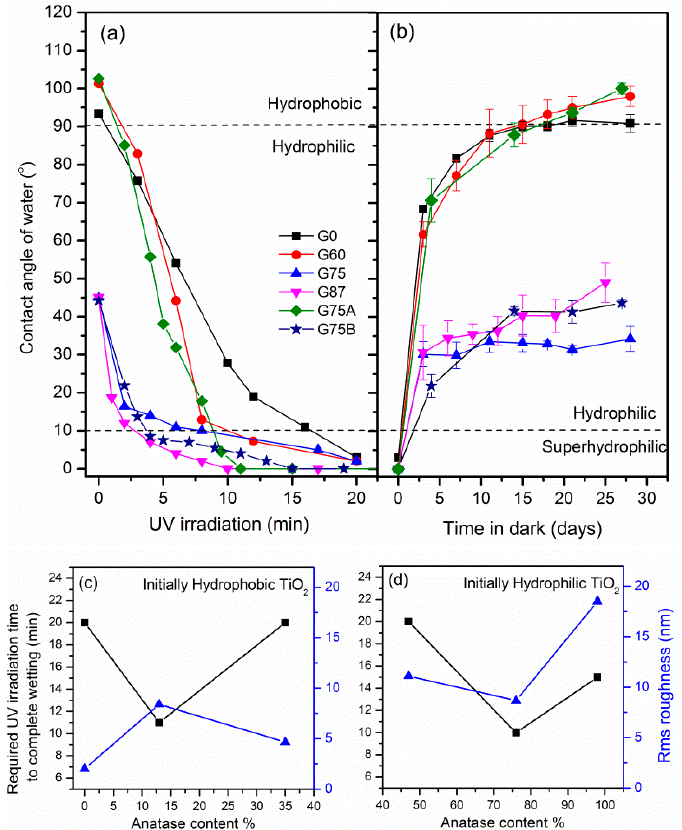
Figure 9. ( a ) Contact angle variation as a function of the elapsed time of exposure of the TiO 2 films under UV radiation (8 mW / cm 2 ) and ( b ) contact angle relaxation during storage of the films in dark ambient conditions after the UV exposure. ( c , d ) Required time of UV illumination in order the TiO 2 films to achieve complete wetting and corresponding surface roughness versus the content in anatase. Note: separate graphs of the initially hydrophobic rutile rich TiO 2 and the initially hydrophilic anatase rich TiO 2 are plotted due to the di ff erence in the extent of the superhydrophilic photoconversion. ( c , d ) are not comparable.